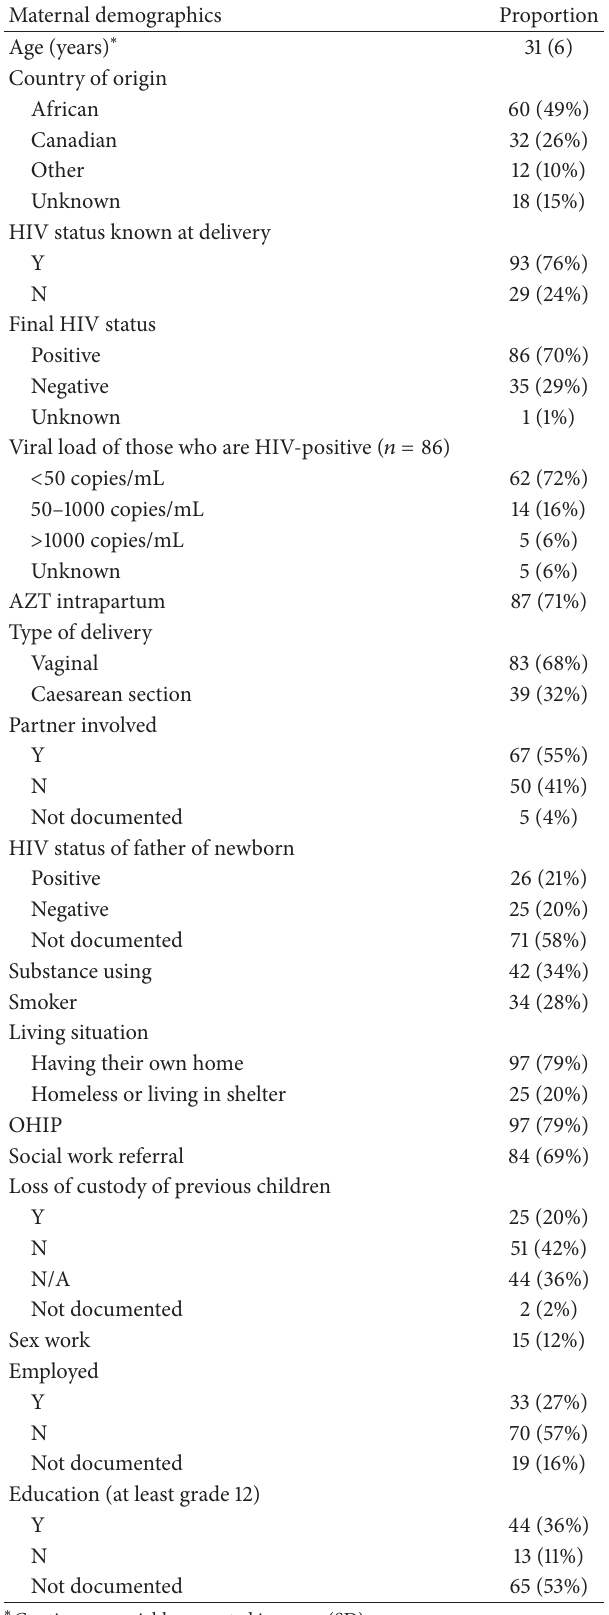
Table 1: Summary of maternal